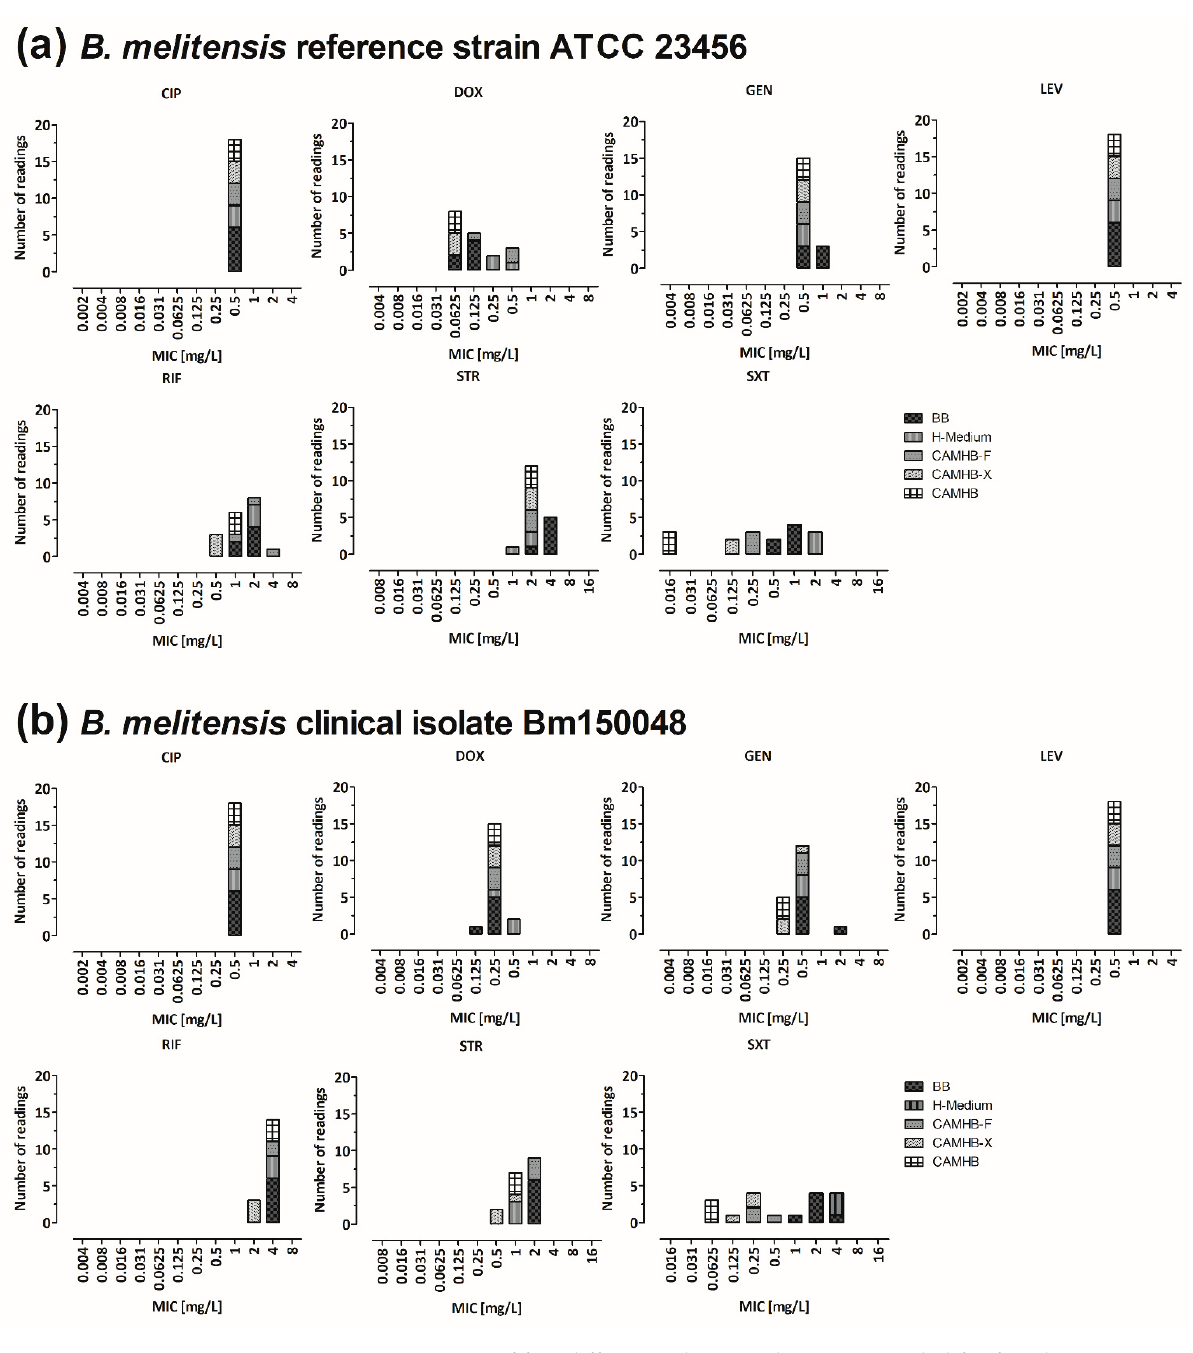
Figure 2. Comparison of five different culture media recommended for fastidious organisms (BB, CAMHB, CAMHB-F, CAMHB-X and H-medium). The BMD was performed in triplicates using CAMHB, CAMHB-F, CAMHB-X and H-medium, and six times for BB. The MIC values were determined after incubation in a 5% CO 2 atmosphere for 48 h. ( a ) B. melitensis reference strain ATCC 23456 showed comparable MIC values for gentamicin and streptomycin for all five culture media. For trimethoprim–sulfamethoxazole, the observed MIC values showed a range of eight log 2 dilution steps: the lowest MIC value was measured for CAMHB (0.016 mg/L), which was five log 2 dilutions lower than for BB (0.5 and 1.0 mg/L); the other media showed one to two log 2 dilutions lower MIC values than BB (CAMHB-X: 0.125 mg/L; CAMHB-F: 0.25 mg/L), and the highest MIC-value was observed for H-medium (2 mg/L). For doxycycline, the obtained MIC values covered a range of four